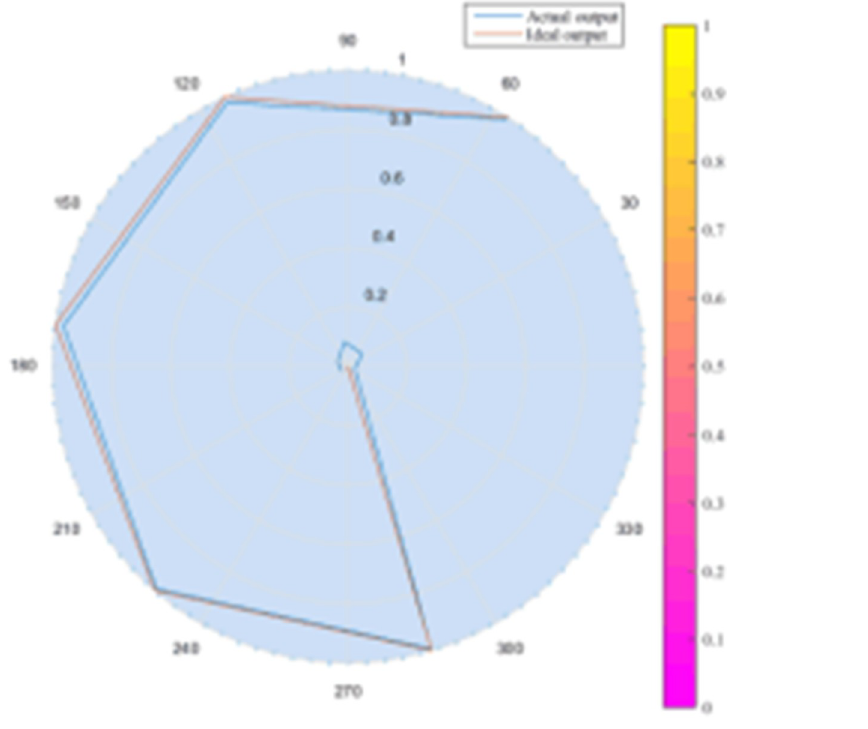
Fig 7. Analysis of ANN4 test results.